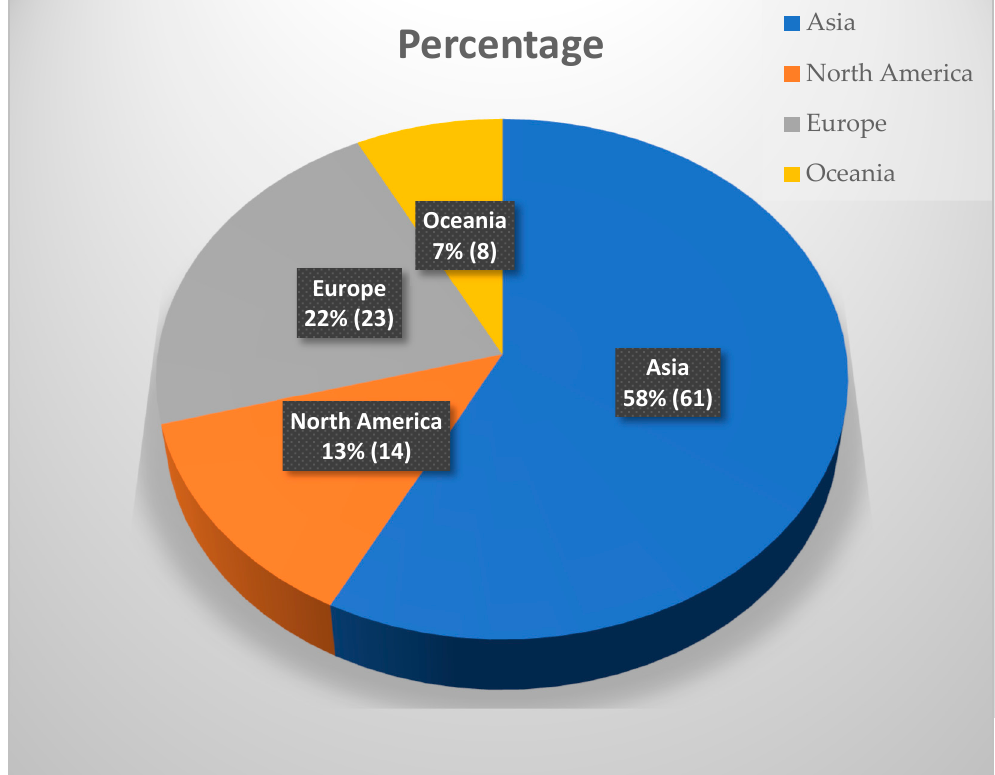
Figure 6. The Percentage of Reviewed Articles Published Per Continent.